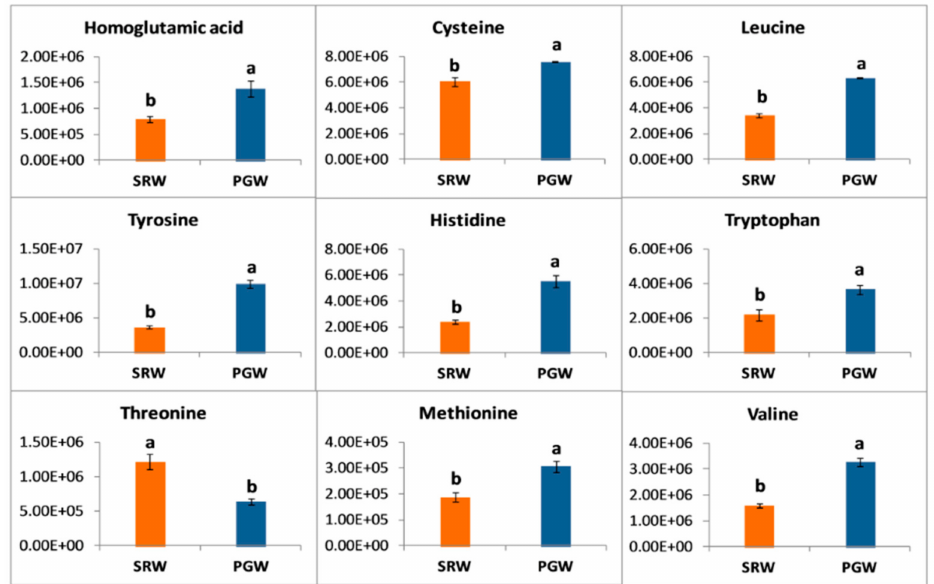
Figure 5. Y -axis shows the differences in relative contents of amino acids between mature fruit of pumpkin-grafted watermelon (PGW) and self-rooted watermelon (SRW). Vertical bars represent standard error among three independent replicates. Data are the mean ± SE of three replicates. Different lowercase letters indicate significant differences at p <